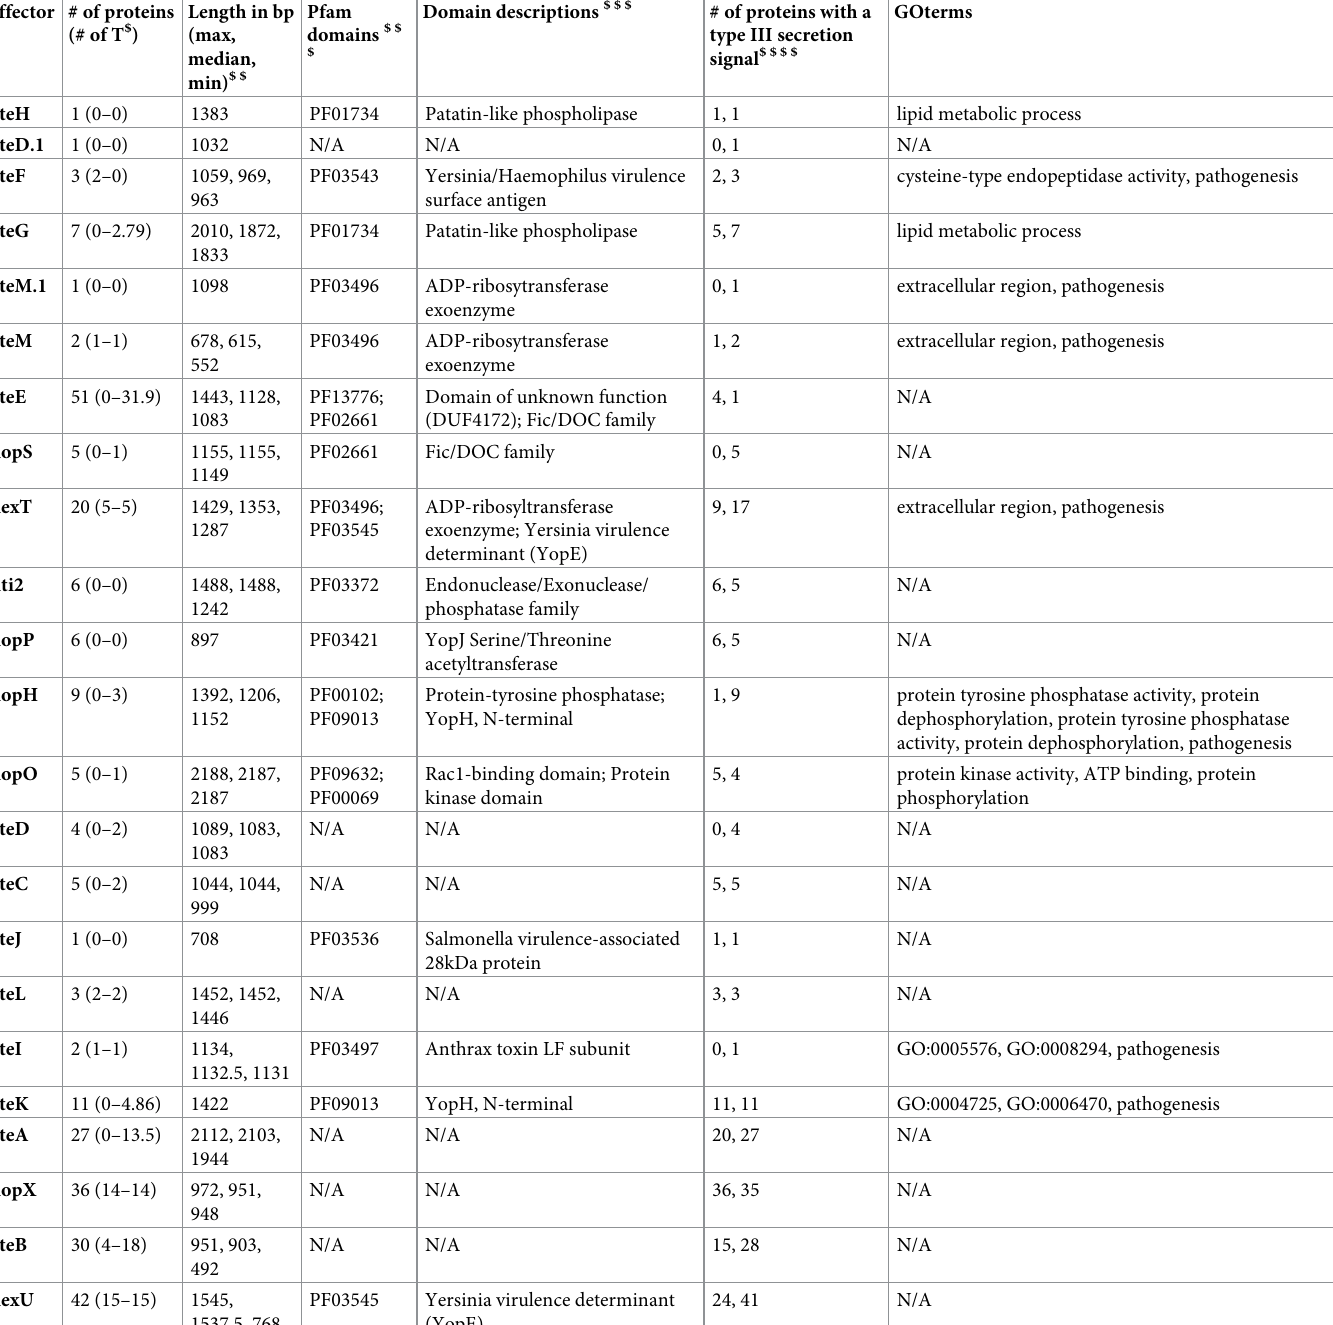
Table 1. Relevant characteristics of putative T3SS effector groups. Number of proteins describes the total number of protein-encoding genes identified across all assayed genomes for a given group. Effector # of proteins (# of T $